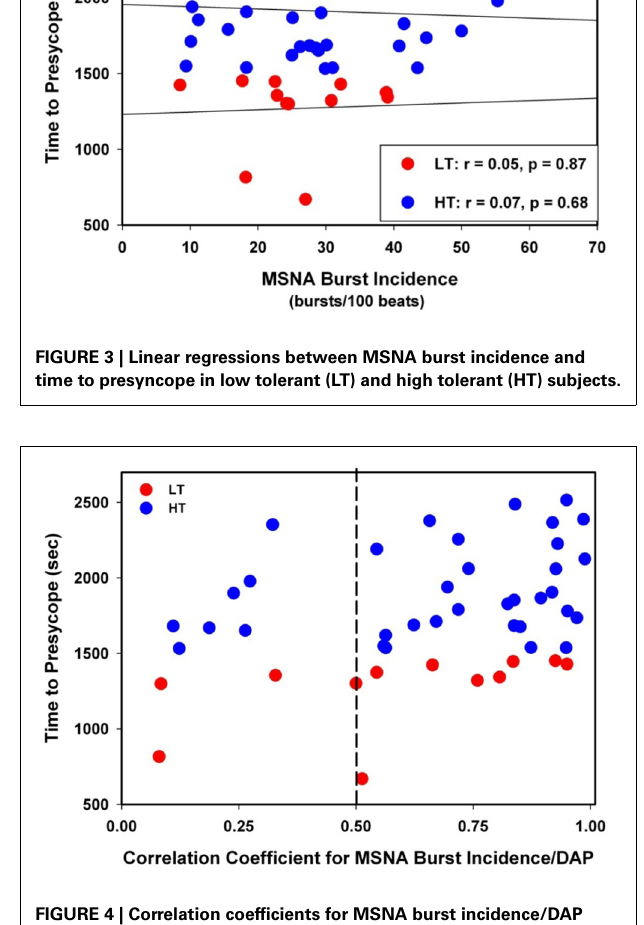
FIGURE 4 | Correlation coefficients for MSNA burst incidence/DAP slopes plotted against time to presyncope in low tolerant (LT) and high tolerant (HT) subjects. Only subjects with correlation coefficients ≥ 0.5 were evaluated for MSNA baroreflex sensitivity by burst incidence (75% of LT; 80% of HT; p = 0 .